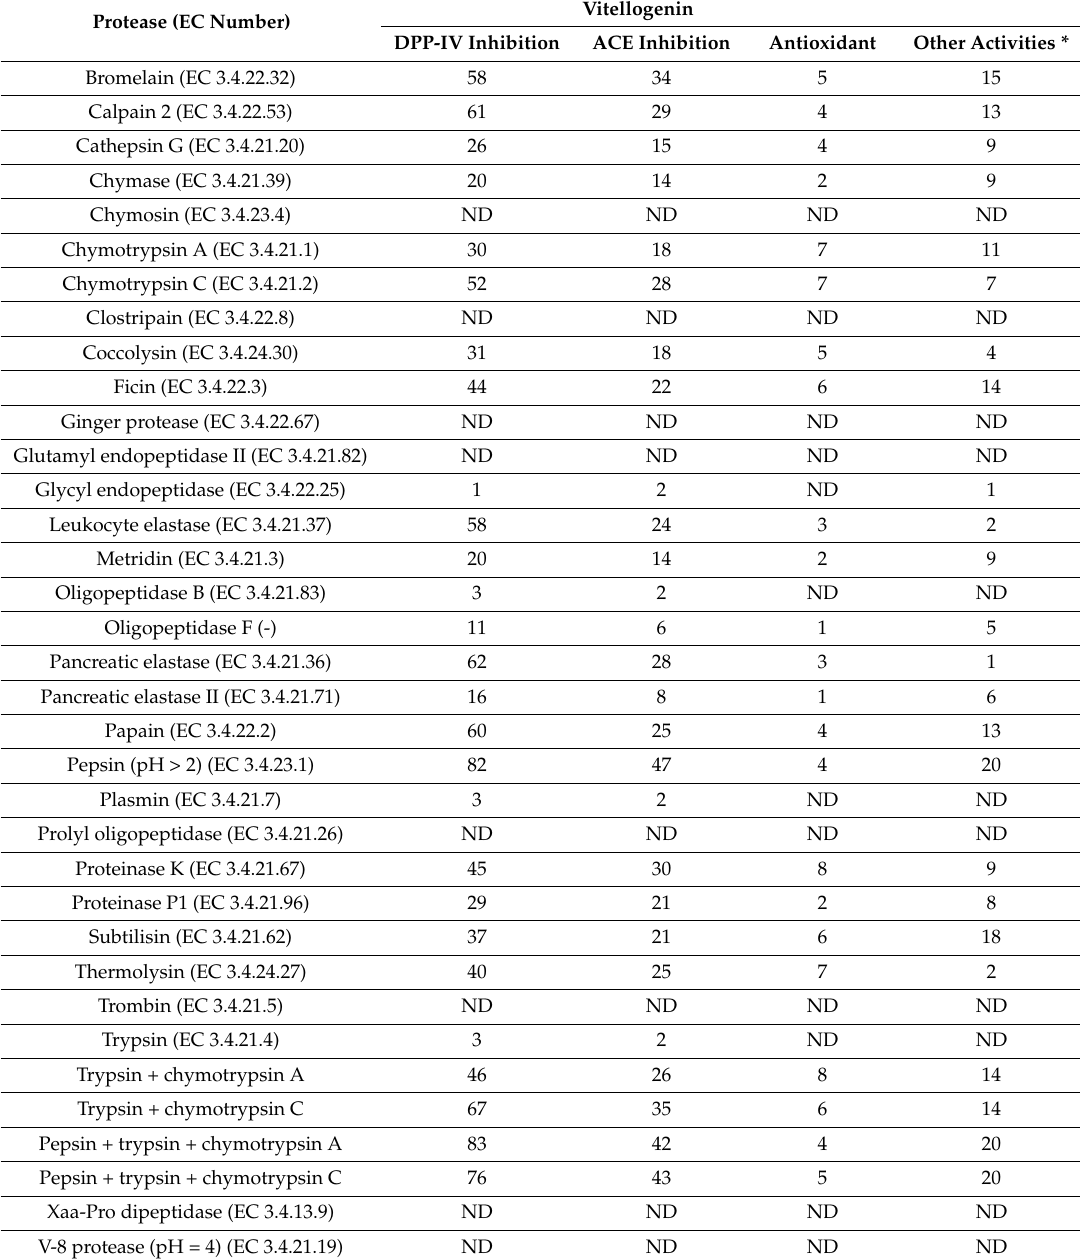
Table 3. Prediction of potential bioactive hydrolysates of vitellogenin protein (Accession